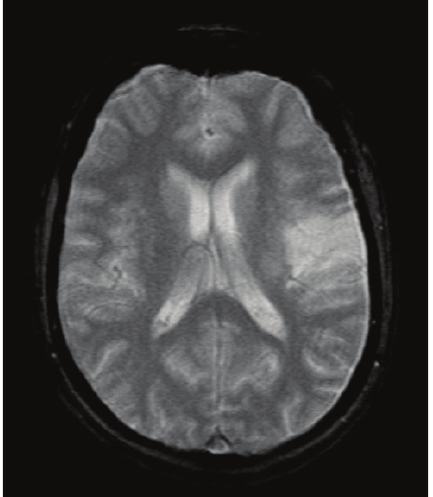
Figure 8: T2WI-MRI scan after one year demonstrating regression of the previous infarction.